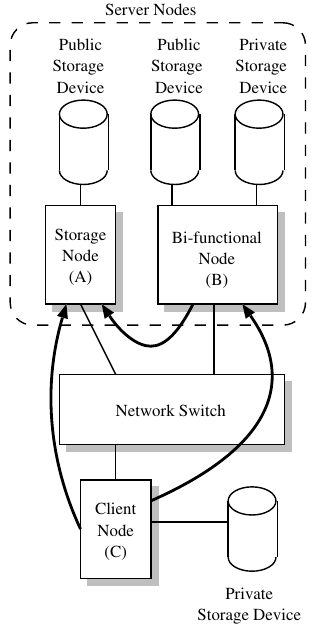
Fig. 1. An example of network nodes’